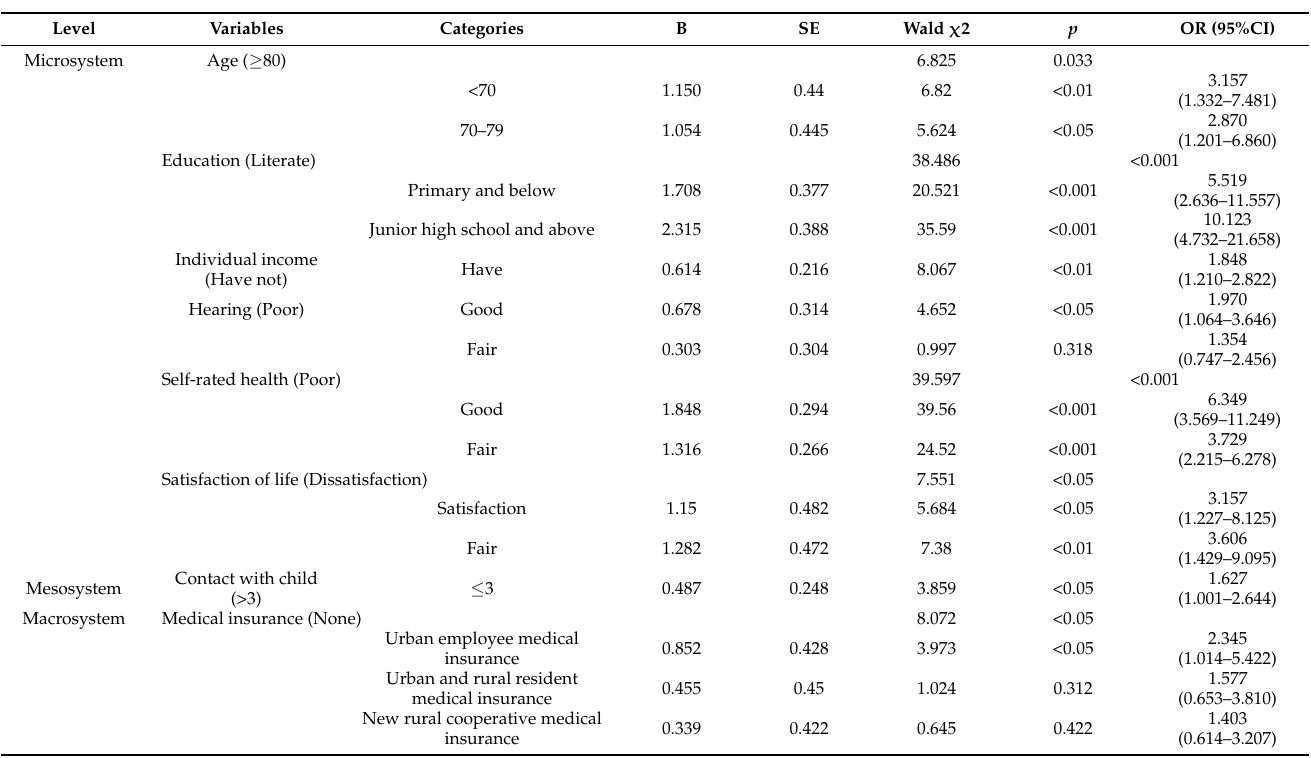
Table 3. Multiple logistic regression for successful